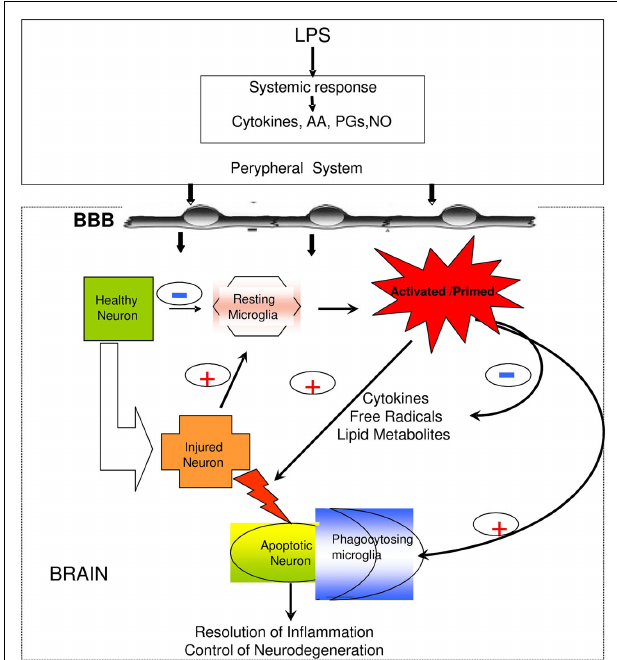
FIGURE 1 | Peripheral infection/inflammation causes the release of pro-inflammatory mediators, including cytokines (TNF- α , IL-1 β , IL-6), arachidonic acid (AA), prostaglandins (PGs), and nitric oxide (NO) synthesis. The brain also mounts an inflammatory response to systemic inflammation, as well as to local injury (neurodegeneration, trauma, stroke), with the microglial cells responding soonest and with production of the greatest amounts of pro-inflammatory mediators. However, the central response appears to be under tighter control than the peripheral response in that it is delayed and more modest, probably in order to avoid the dire consequences of a full-blown inflammatory response within the confines of the skull. Modified after Solito et al.